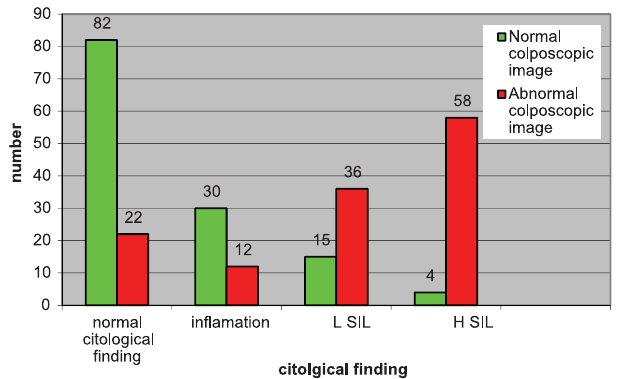
FIGURE 6. There is a signi fi cant difference in the distribution of colposcop- ic images by cytological fi ndings. Most abnormal colposcopy fi ndings are in category of cytological fi ndings HSIL and LSIL (Pearson Chi-Square,